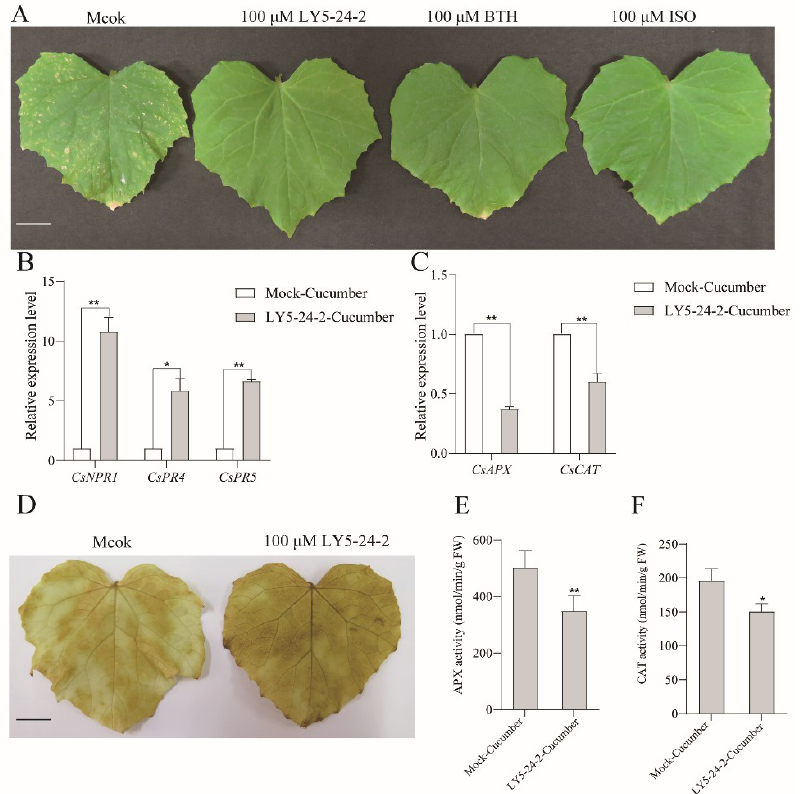
Figure 8. LY5-24-2 promoted resistance of cucumber to P. cubensis . ( A ) Phenotypes of leaves of cucumber inoculated with P. cubensis at 24 h after a treatment with 100 µ M of LY5-24-2, BTH or ISO. The 21-day-old cucumber seedlings were spray-inoculated with P. cubensis. Leaves were harvested at 7 dpi. Bars, 2 cm. ( B ) Analysis of CsNPR1 , CsPR4 and CsPR5 expression in cucumber leaves at 24 h after a treatment with 100 µ M of LY5-24-2. ( C ) Analysis of CsAPX and CsCAT expression. CsActin was served as an internal control. ( D ) DAB staining in cucumber at 24 h after a treatment with 100 µ M of LY5-24-2. Bars, 2 cm. ( E ) Analysis of APX activity in cucumber at 24 h after a treatment with 100 µ M of LY5-24-2. ( F ) Analysis of CAT activity. Data are shown as the mean of three biological replicates ± SD. The * represent significant difference (* p < 0.05, ** p < 0.01, Student’s t